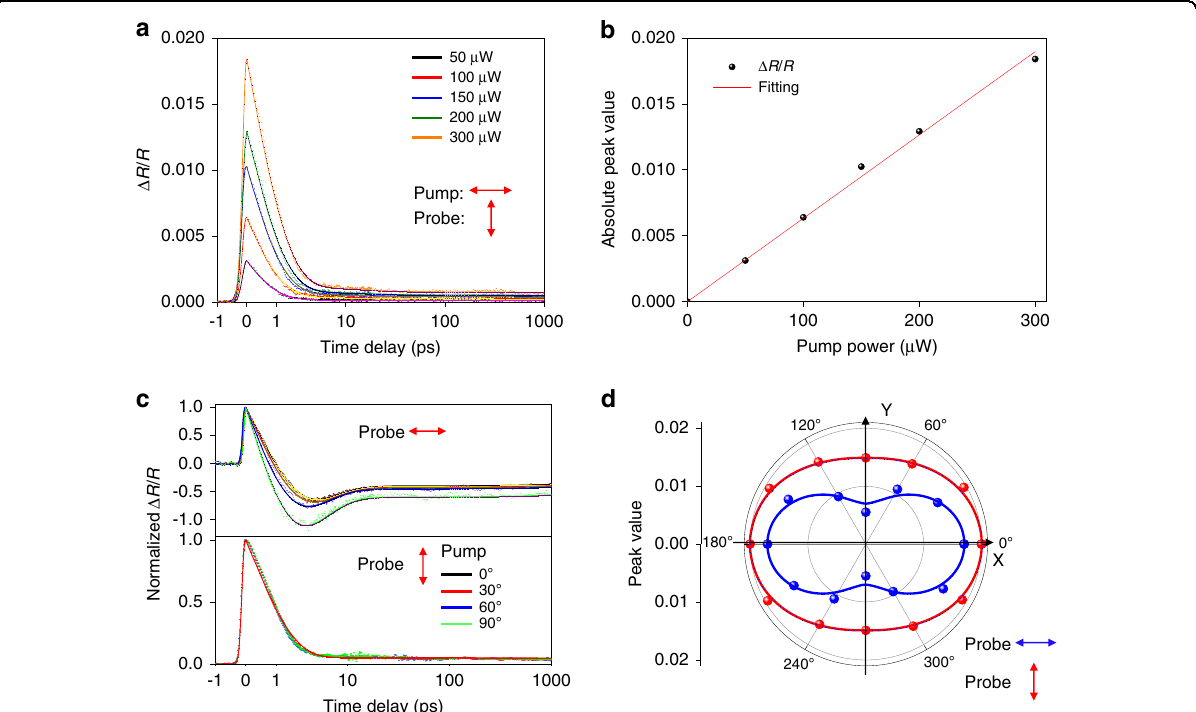
Fig. 3 Pump power and polarization dependence of transient dynamics. a The dependence of Δ R / R on pump power with cross-polarized pump and probe polarization (0° and 90° for pump and probe, respectively) at room temperature. b The dependence of Δ R / R | t = 0 on pump power. The experimental data are fi t linearly with a red line. c Pump polarization dependence of normalized Δ R / R at room temperature. The pump power is 300 μ W. The curves are fi tted by Δ R / R = A 1 e (cid:1) t = τ 1 þ A 2 e (cid:1) t = τ 2 þ A 3 e (cid:1) t = τ 3 and normalized by the positive peak values at time zero. d The dependence of Δ R / R | t = 0 on pump polarization with 0°(blue) and 90°(red) probe polarization. The results with probe polarization along 0° have been quadrupled for clarity and the fi tting equation is: Δ R / R | t = 0 = B 1 cos 2 ( α 1 ) + B 2 sin 2 ( α 1